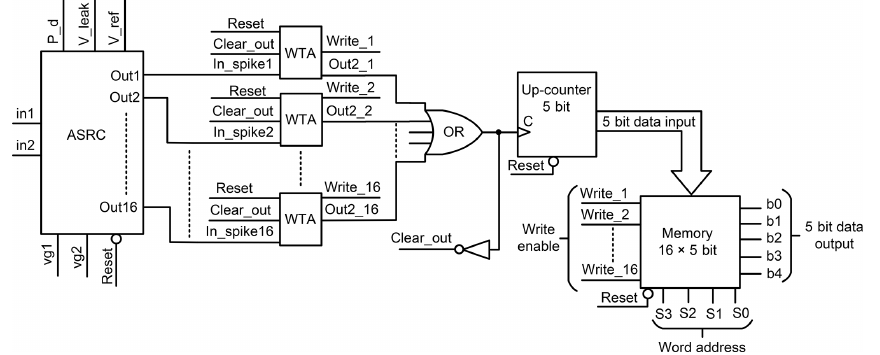
Figure 18. Proposed ASDC and memory. The ASDC block generates a digital code and saves it in the memory, based on the time difference between the spikes on its inputs. Every output of ASRC is connected to a single cell of the winner-take-all (WTA) circuit. There is a position in the memory for every cell of the WTA to save its order among the other ASRC outputs.